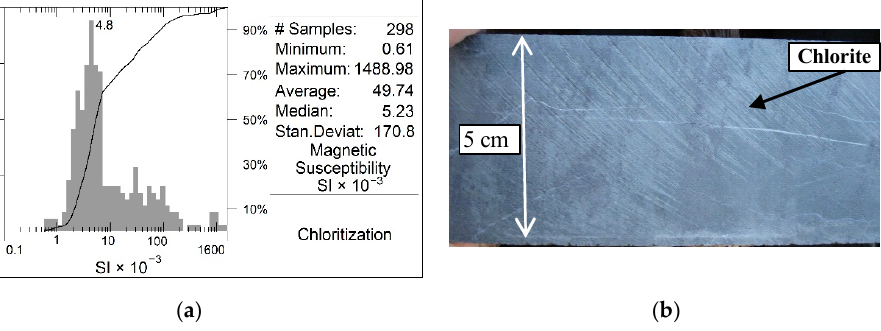
Figure A5. Chloritization (Chl). ( a ) Statistics and histograms of the magnetic susceptibility measurements. ( b ) Core sample picture.